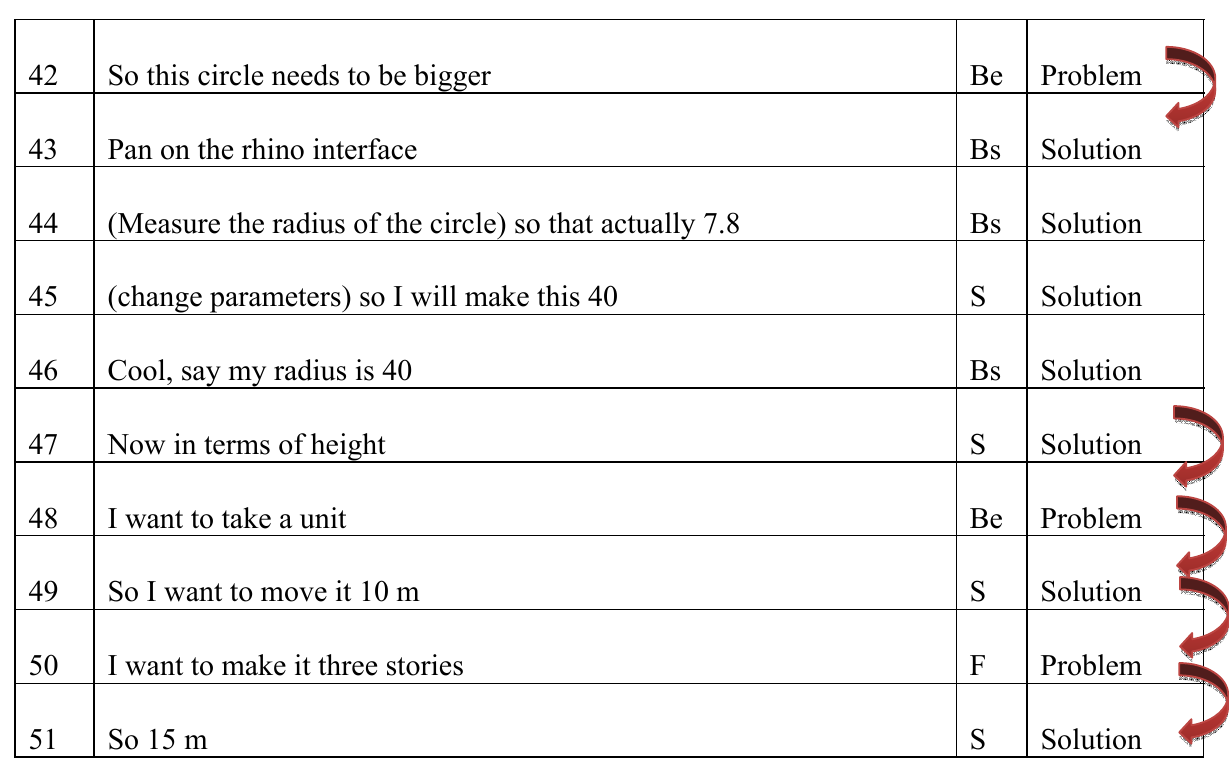
Figure 8. Example of the discontinuity transition between the design problem and solution